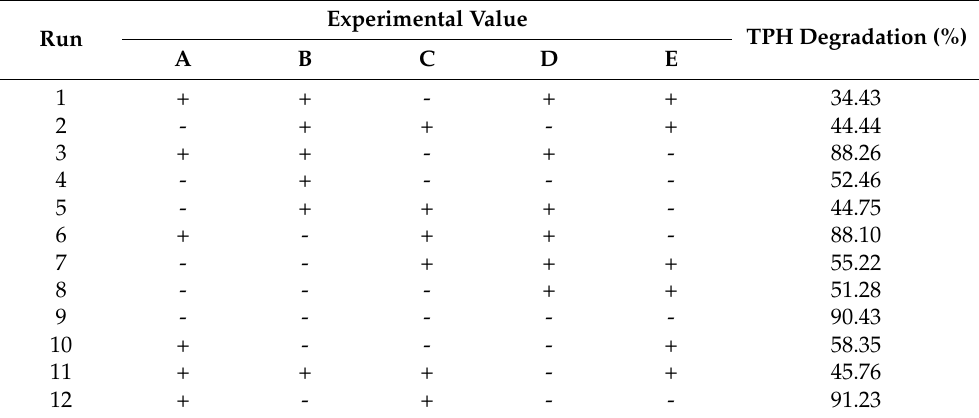
Table 2. Plackett–Burman design (PBD) permutation matrix for the identification of significant factors and the corresponding TPH degradation efficiency by consortium BS24.